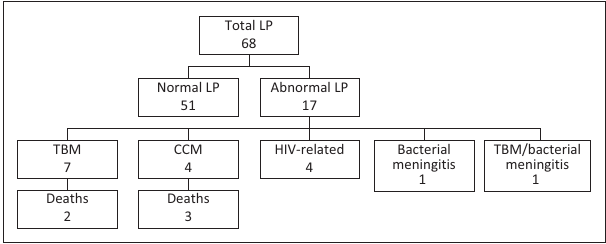
FIGURE 1: Lumbar puncture